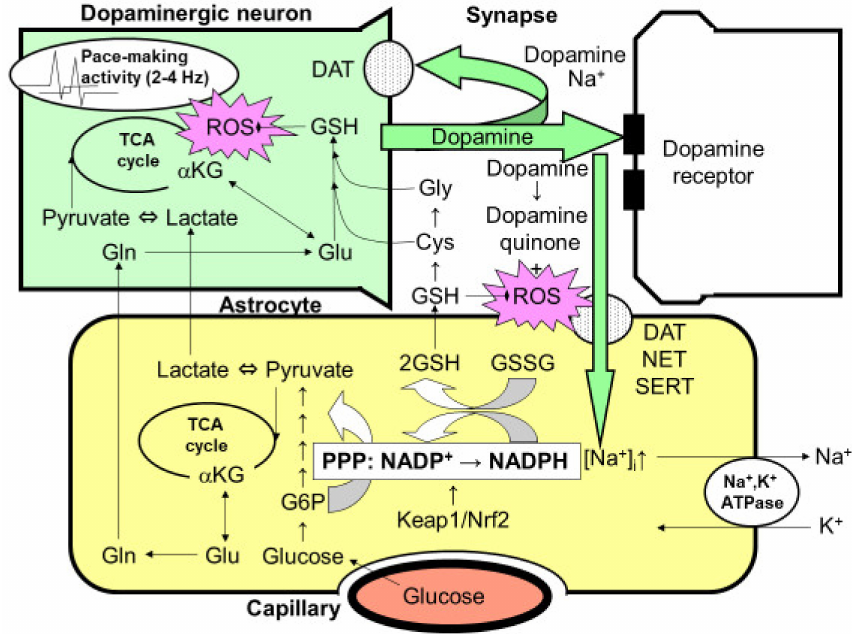
Figure 3. Possible interaction between astrocytes and dopaminergic nerve terminals. The optimal dopamine concentration is maintained in the striatum by the 2–4-Hz pace-making activity of dopamin- ergic neurons in the substantia nigra. However, this constant activity can elicit mitochondrial overload during oxidative metabolism, leading to the increased production of reactive oxygen species (ROSs). The reduced form of glutathione (GSH) plays an important role in eliminating ROSs. The synthesis of glu- tathione requires glutamine (Gln)/glutamate (Glu), which is supplied by astrocytes, as well as cysteine (Cys) and glycine (Gly), which are also derived from GSH released from astrocytes. Thus, neuronal GSH synthesis is largely dependent on astrocytes. After dopamine is released from the presynaptic terminals of dopaminergic neurons, it is taken up by Na + -dependent dopamine transporter (DAT) expressed in presynaptic neurons. However, the astrocytes that surround the synapses also seem to take up dopamine via two astrocytic Na + -dependent monoamine transporters: norepinephrine transporter (NET) and serotonin transporter (SERT). Increases in the intracellular Na + concentration ([Na + ] i ) activate Na + , K + -ATPase, thereby enhancing glycolytic metabolism (aerobic glycolysis) in astrocytes. The